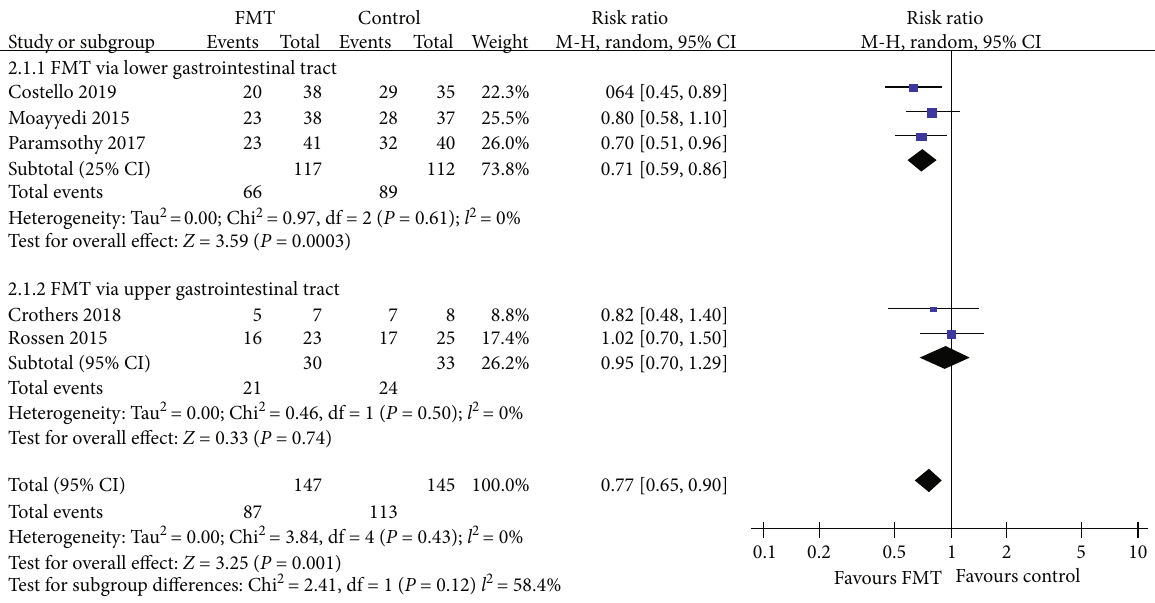
Figure 6: Forest plot of studies reporting clinical remission and subgroup analysis according to di ff erent delivery